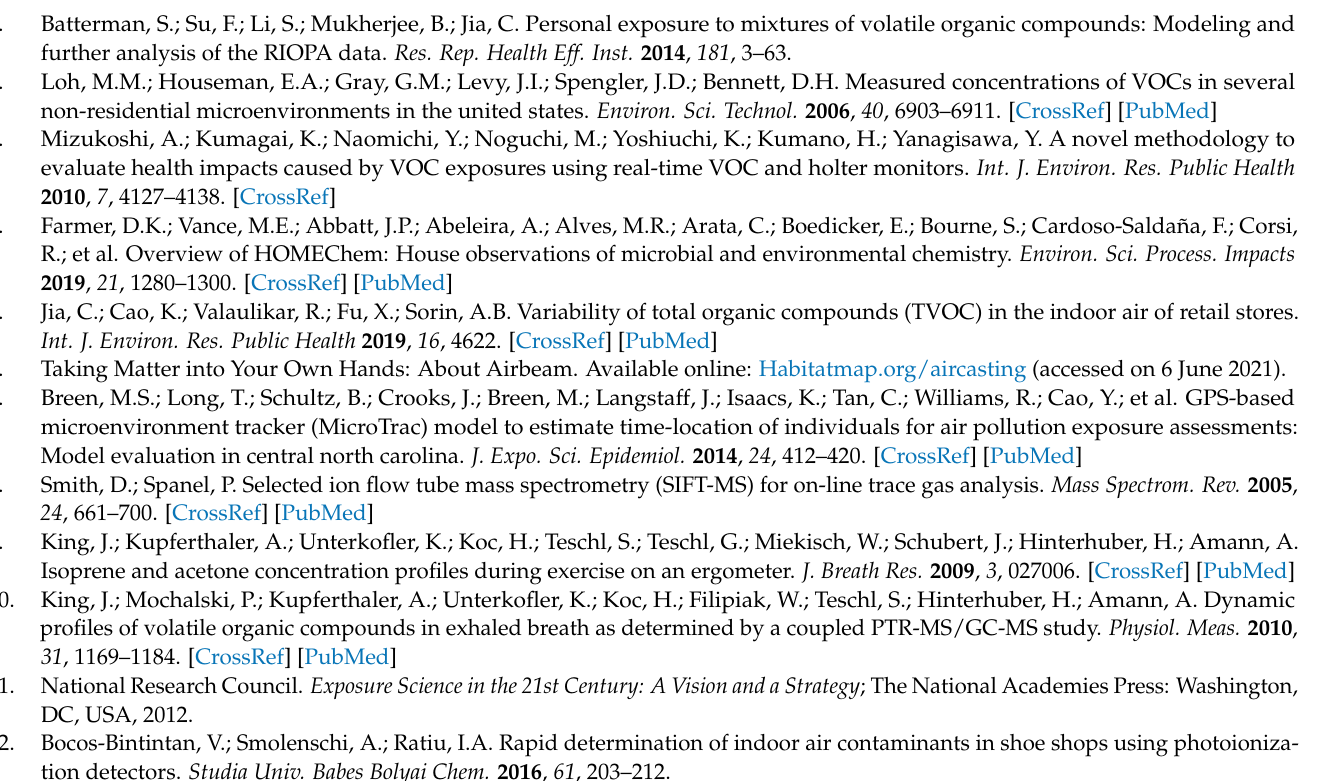
1-min TVOC exposures and ME. Table S5. Summary table of house characteristics, weather, and air exchange rates. Table S6. Characteristics of the HEE at “Home-In” locations. Table S7. Characteristics of the HEE at “Other-In” locations. Table S8. Characteristics of the HEE at “In-Vehicle” locations. Table S9. Characteristics of the HEE at “Out”